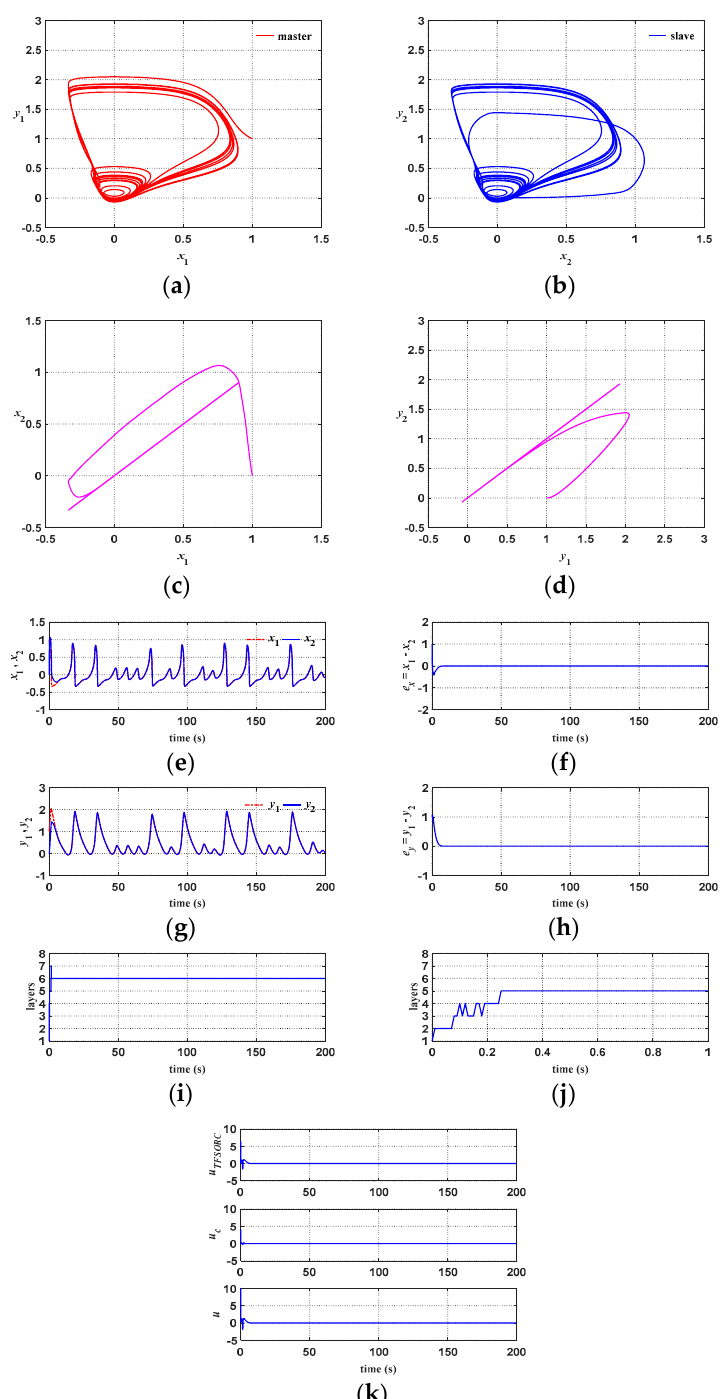
diagram; ( b ) Slave system phase diagram; ( c ) x 1 , x 2 phase diagram; ( d ) y 1 , y 2 phase diagram.